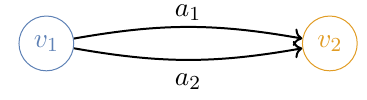
Figure 6. The Kronecker-2